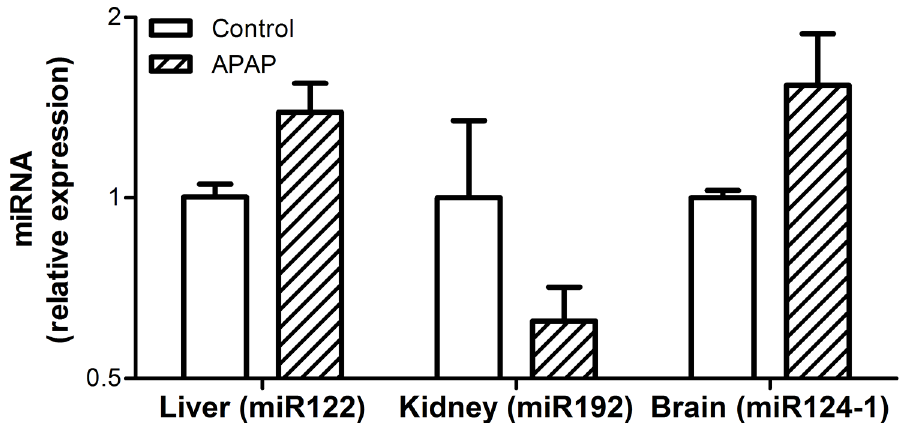
Fig 6. Levels of miR122, miR192 and miR124-1 in their respective tissues. Values are means ± SE of relative expression (2 - ΔΔ Ct ) for APAP-treated animals to both the endogenous control (miR26a) and the time- matched controls; * P < 0.05 vs. baseline at